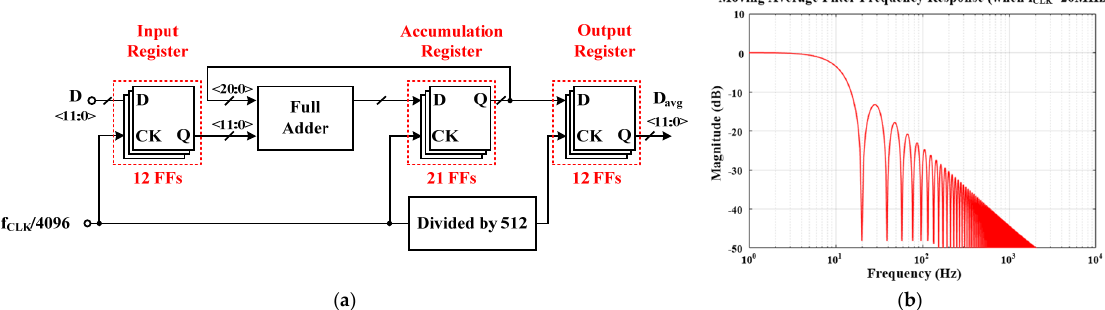
Figure 4. ( a ) Circuit diagram of the moving average filter (MAF); ( b ) its frequency response.